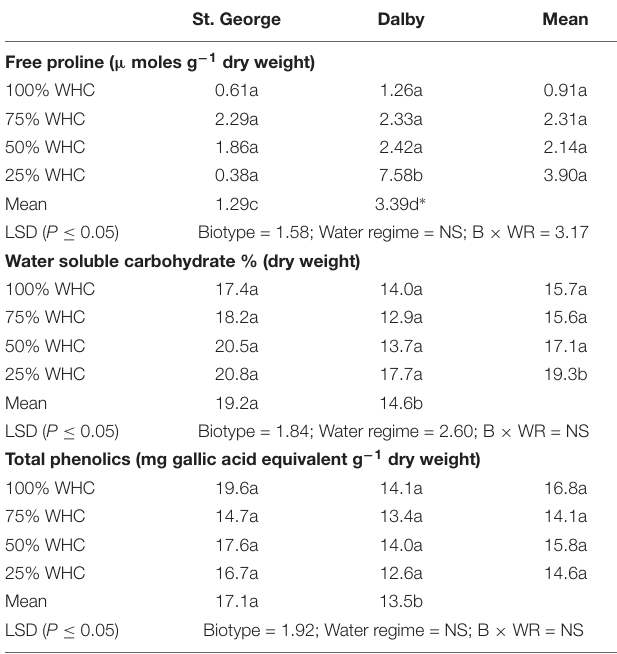
TABLE 2 | Effect of different soil moisture levels (factor 2) on different parameters of two Australian biotypes (St. George and Dalby; factor 1) of Sisymbrium thellungii .Moisture level